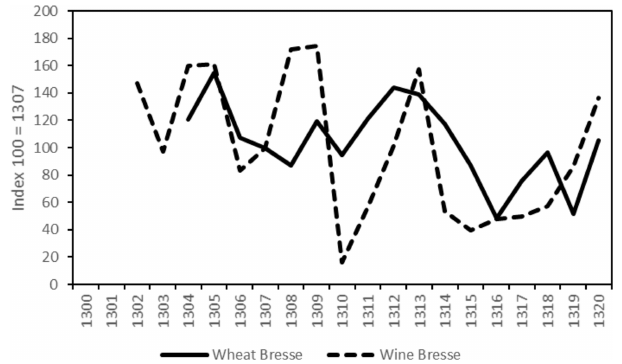
Figure 6. Comparison of cereal production in southern England and the Bresse region (FR). Data: southern England wheat yields (Campbell 2007); Bresse wheat yields (this article); East Anglia JJAS precipitation reconstruction (Pribyl,